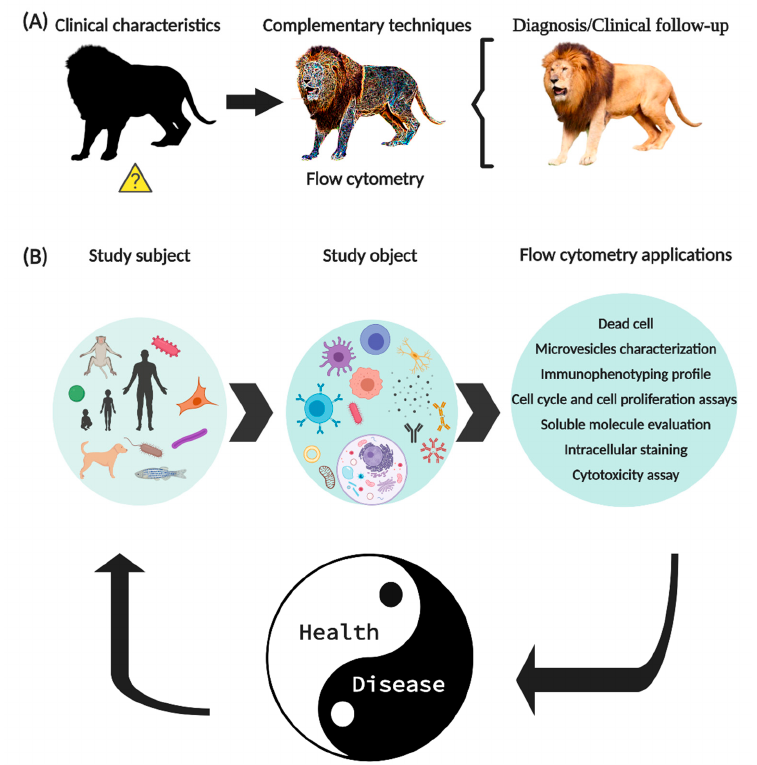
Figure 1. New generation flow cytometry applications. ( A ) FCM is a tool widely used in the clinic